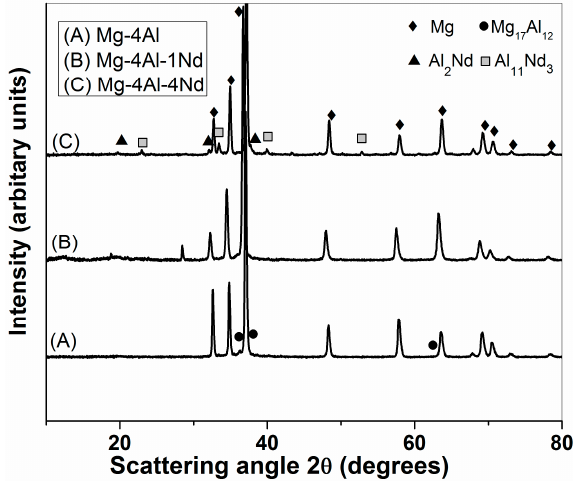
Figure 6. XRD pattern of T6-treated alloys in peak aged conditions.